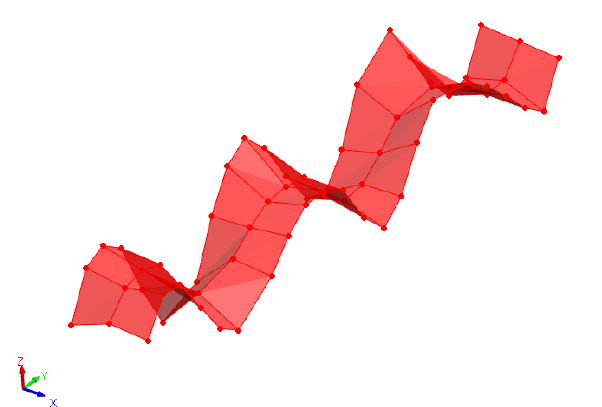
Figure 9. Initial state mode shape ω =